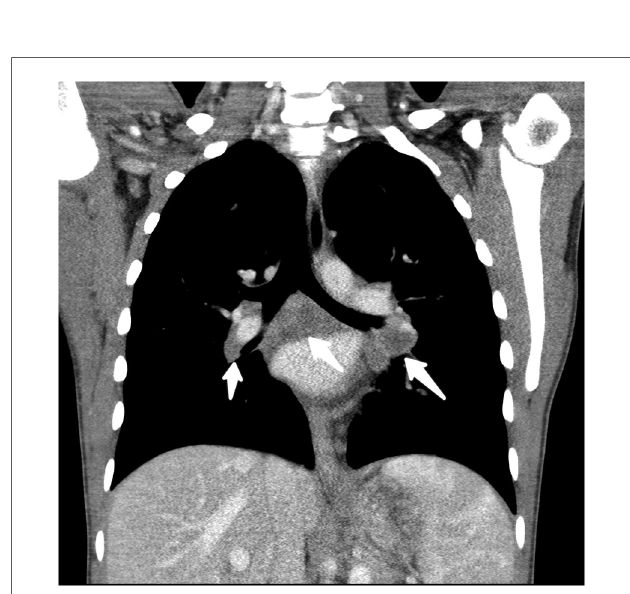
FIGURE 3 Coronal reformatted, soft-tissue window, CT image through the mediastinum with low attenuation, noncalci fi ed, bihilar, and subcarinal adenopathy (white arrows).